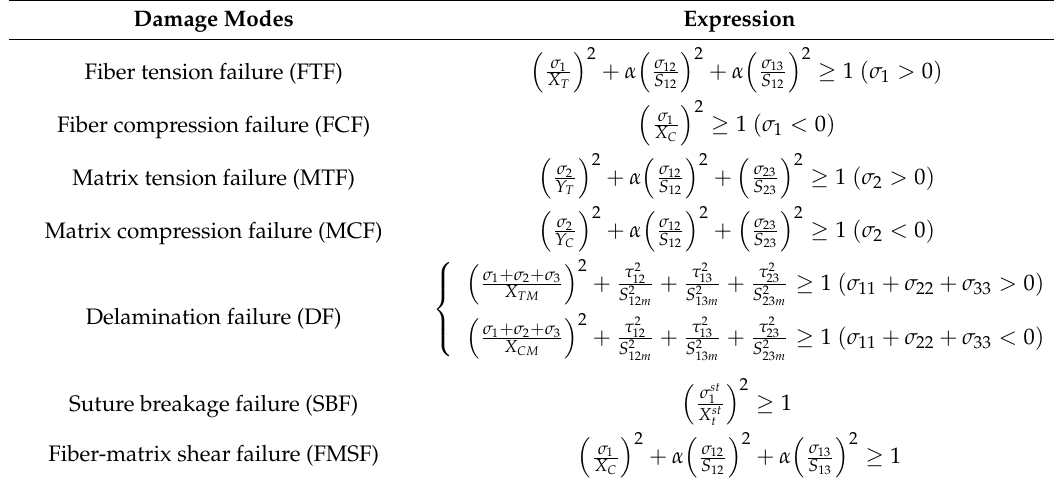
Table 2. Expression of six damage modes for residual